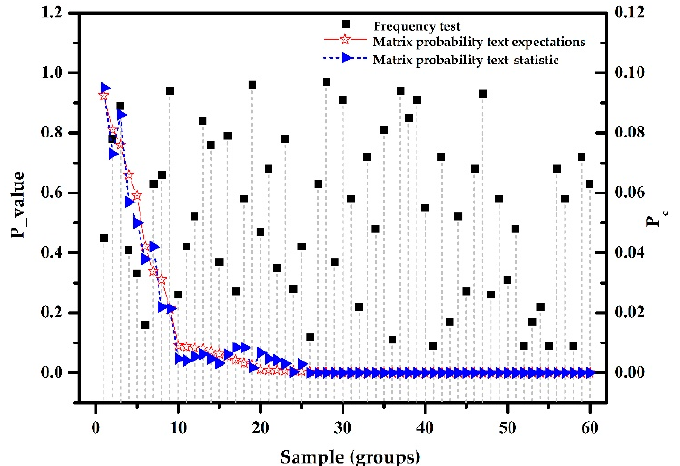
Figure 4. AES CCM* encryption algorithm.